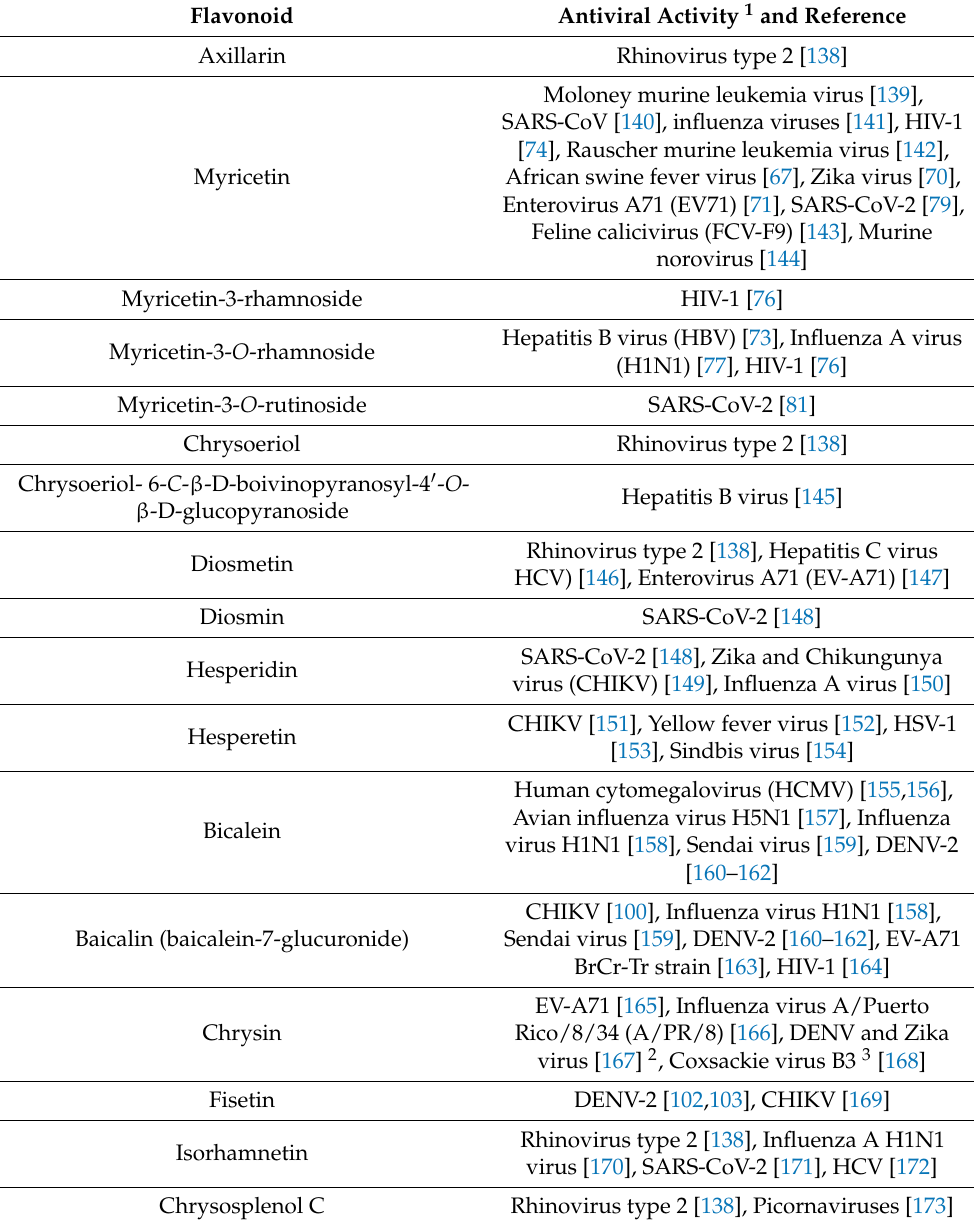
Table 1. Some promising anti-viral